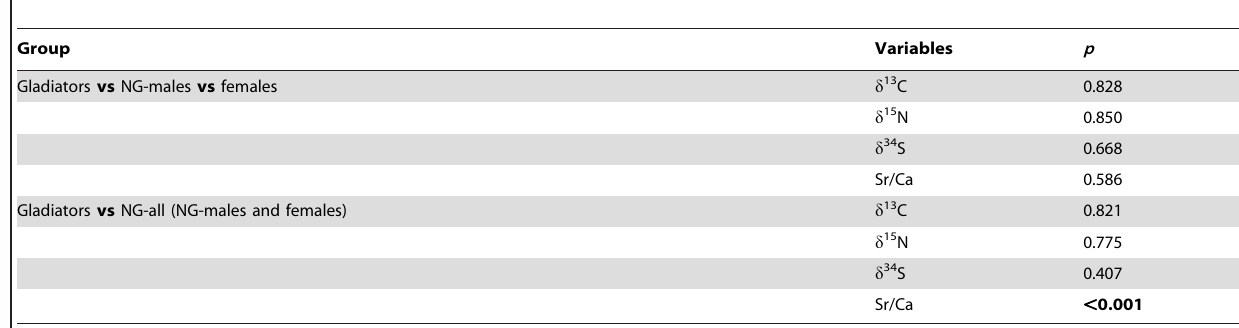
Table 5. Kruskal-Wallis respectively Mann-Whitney U tests performed for gladiator and non gladiator groups.